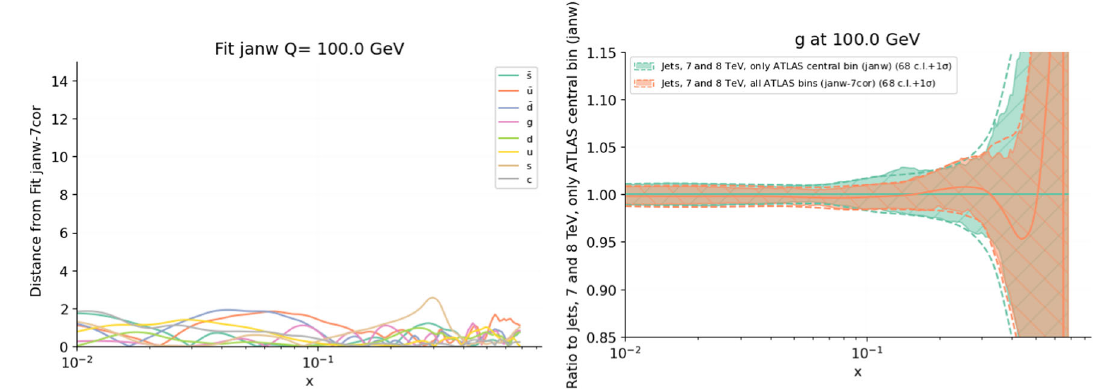
Fig. 10 Same as Fig. 6, but now comparing the default most accu- rate fit to single-inclusive jet data (all datasets, NNLO QCD+EW, fit #janw), in which only the central rapidity bin of the ATLAS 7 TeV data